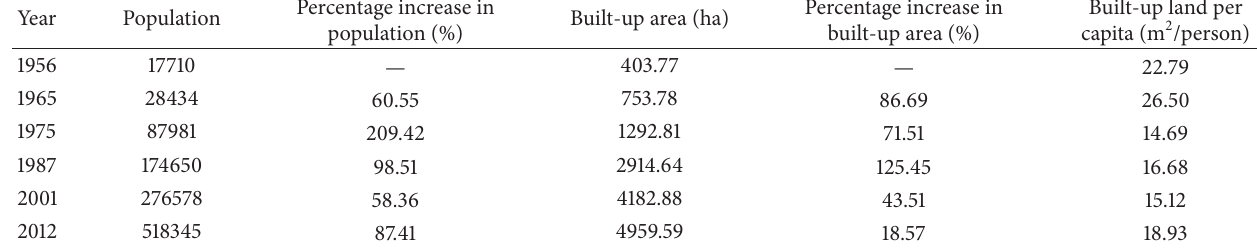
Table 3: The percentage of population and area growth in Bandar Abbas city during 60 years interval.